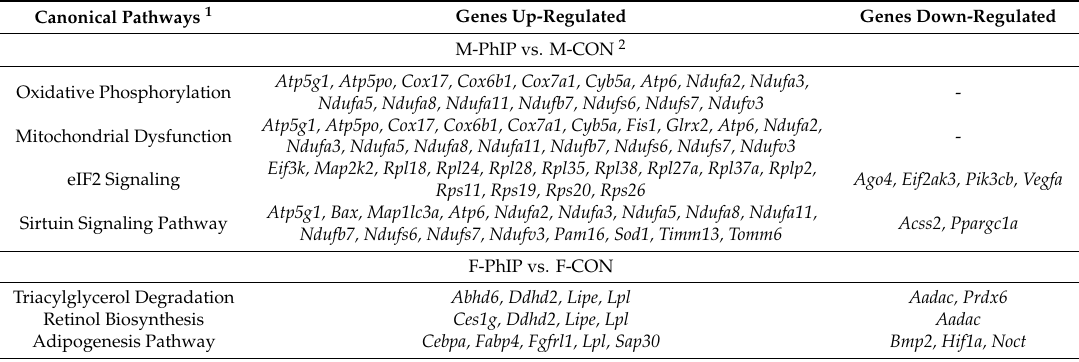
Table 1. List of genes involved in key canonical pathways predicted by the Ingenuity Pathway Analysis (IPA)